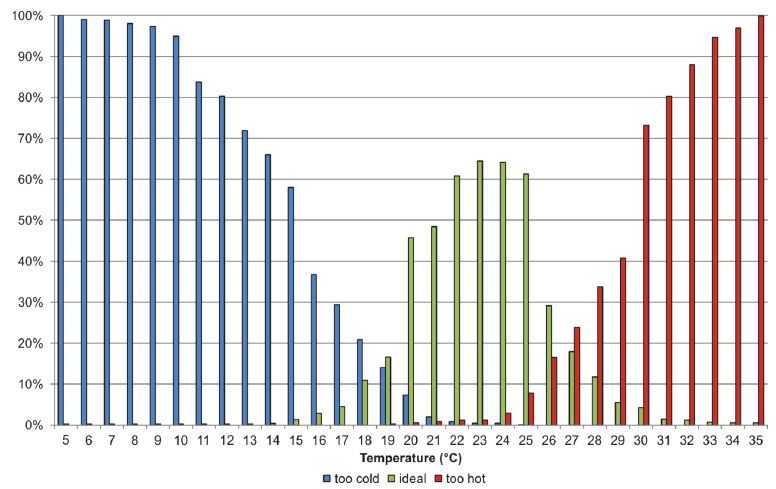
Figure 3. Temperatures perceived as ideal, too hot and too cold. Note: The remaining percentages to 100% are not shown for better readability and refer to temperatures not being chosen by respondents, thus being neither too cold, ideal or too hot.